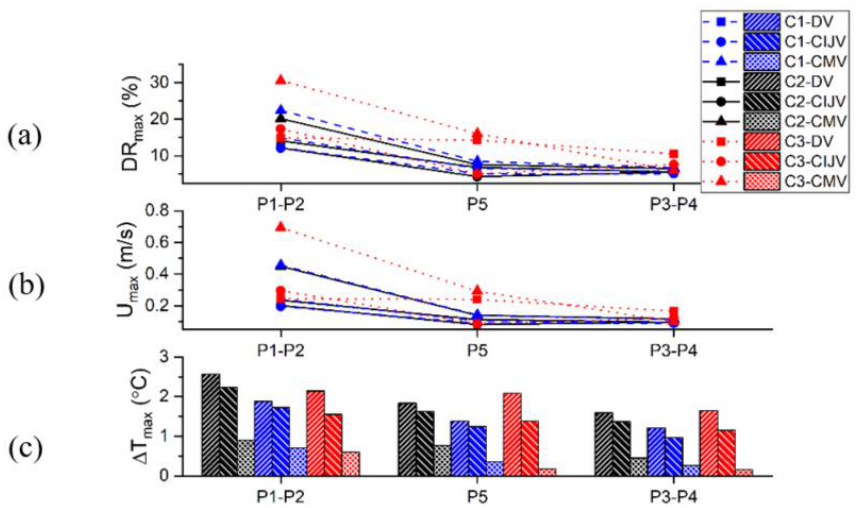
Figure 6. ( a ) Maximum draught rate, ( b ) maximum velocity, and ( c ) maximum temperature difference in positions P1 – P2, P5, and P3 – P4. Table 3. Local discomfort (PD) due to high vertical air temperature difference between head and ankle.